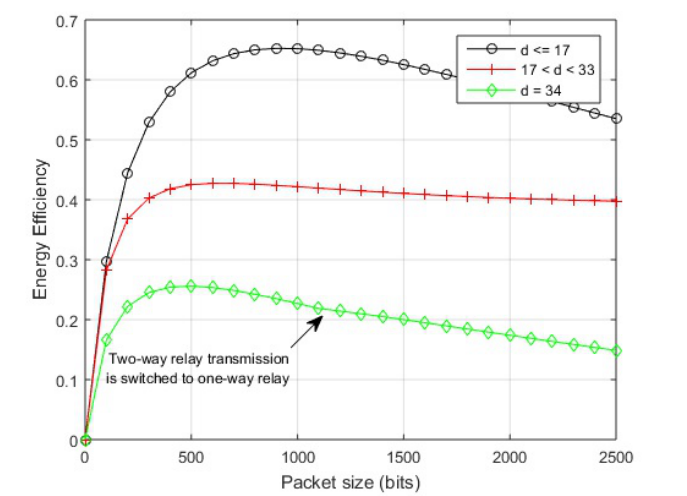
Figure 10. Energy efficiency vs. packet size for proposed scheme (in-body communication).